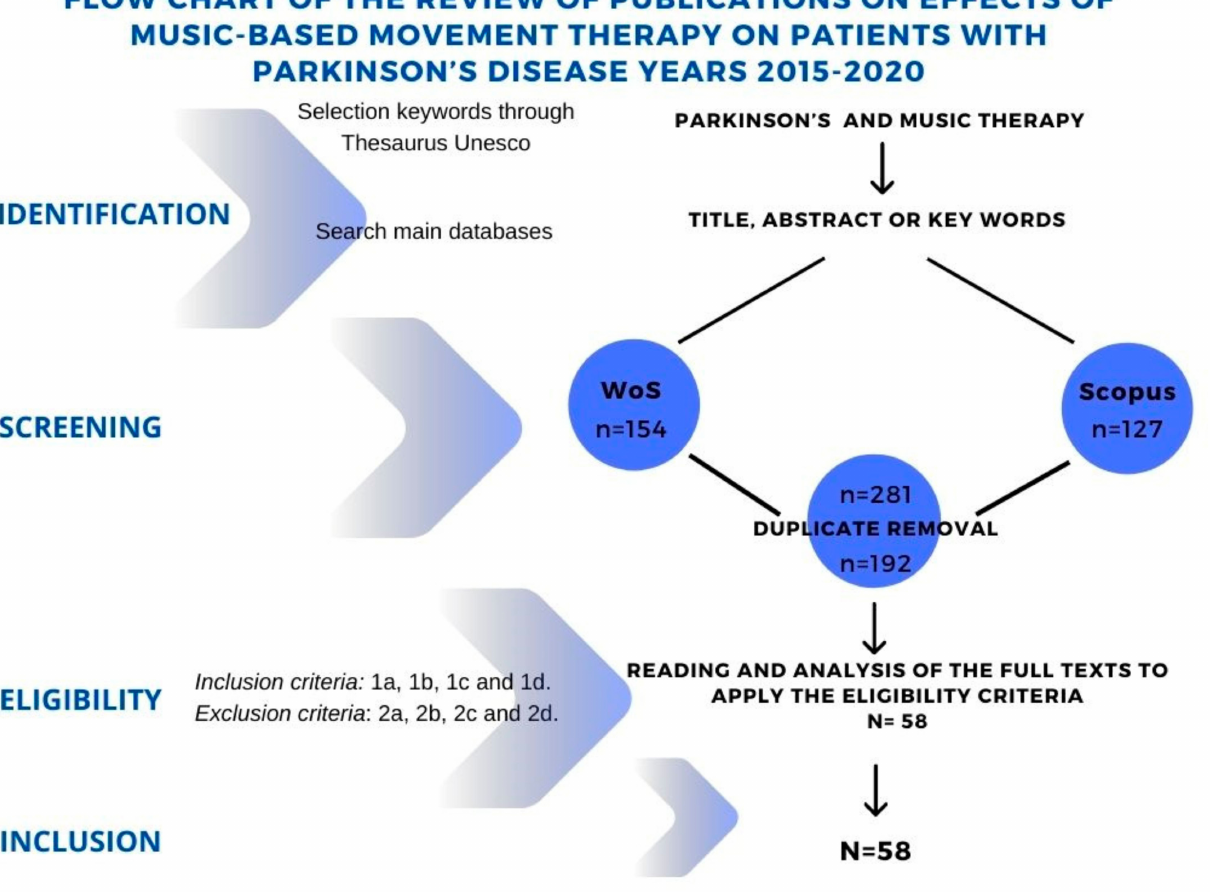
Figure 1. Systematic review flow chart.